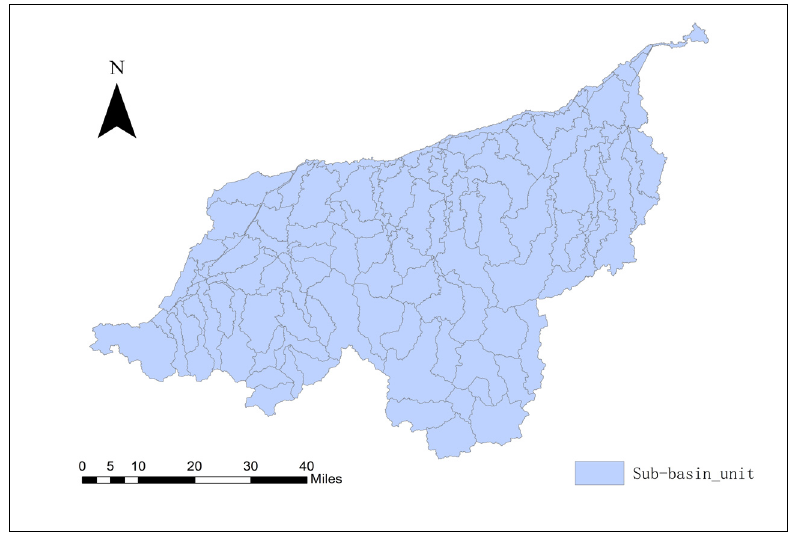
Figure 5. Sub ‐ basin unit map (minimum catchment area threshold, 50 km 2 ). Figure 5. Sub-basin unit map (minimum catchment area threshold, 50 km 2 ).